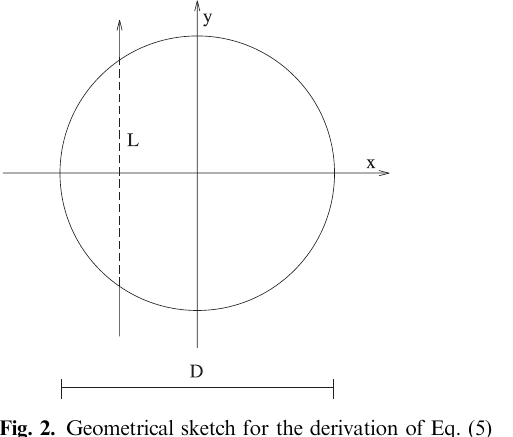
Fig. 2. Geometrical sketch for the derivation of